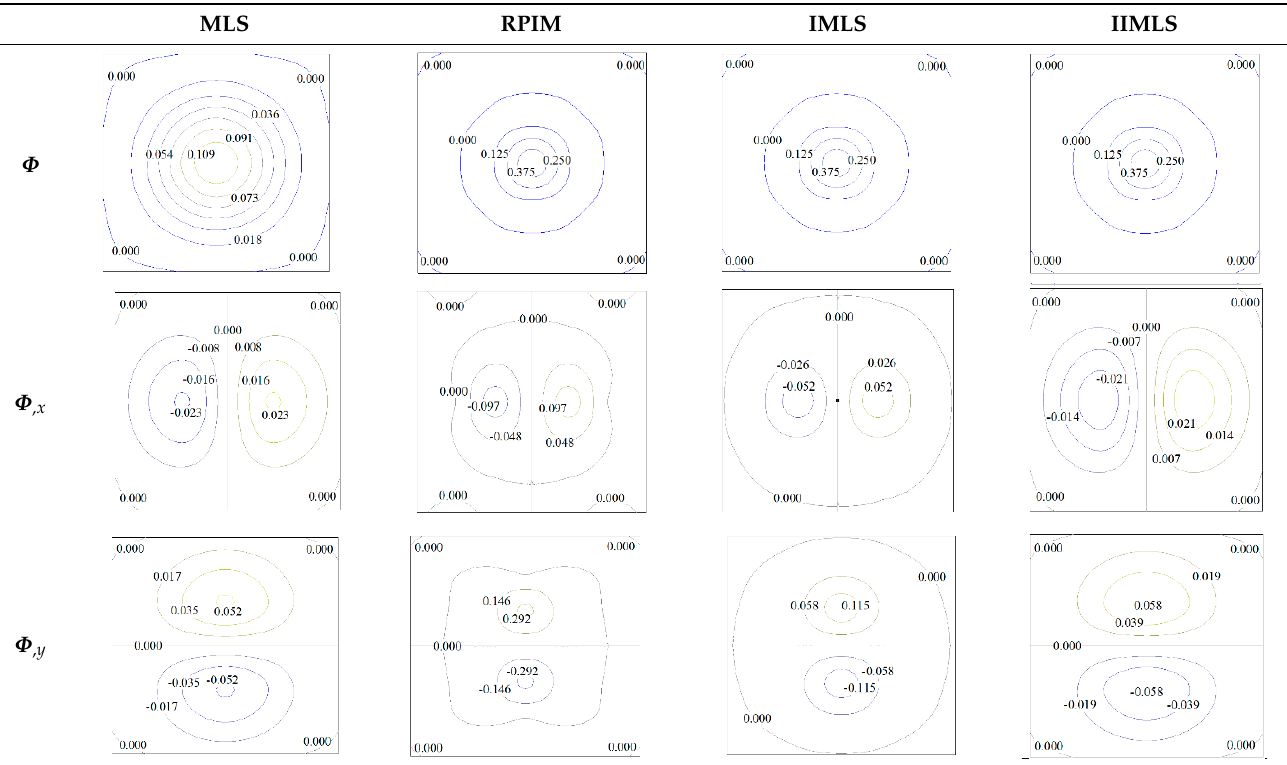
Table 2. Contour plot of the shape functions and their 1st order derivate at point (24, 0) by four different methods.